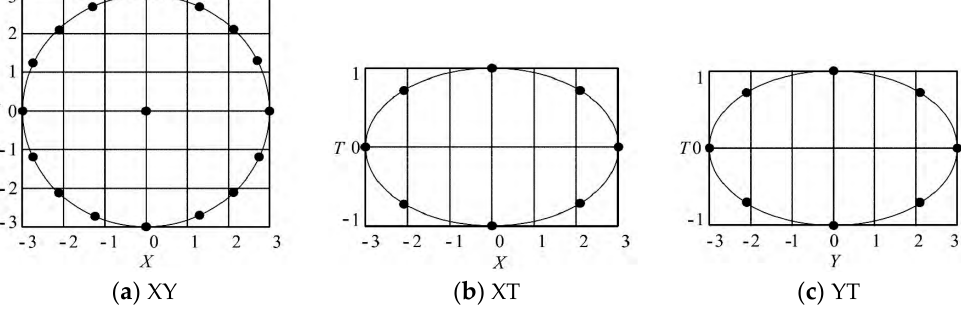
Figure 5. Different radius and numbers of neighboring points on three planes. ( a ) XY orthogonal planes; ( b ) XT orthogonal planes; ( c ) YT orthogonal planes. planes; ( b ) XT orthogonal planes; ( c ) YT orthogonal